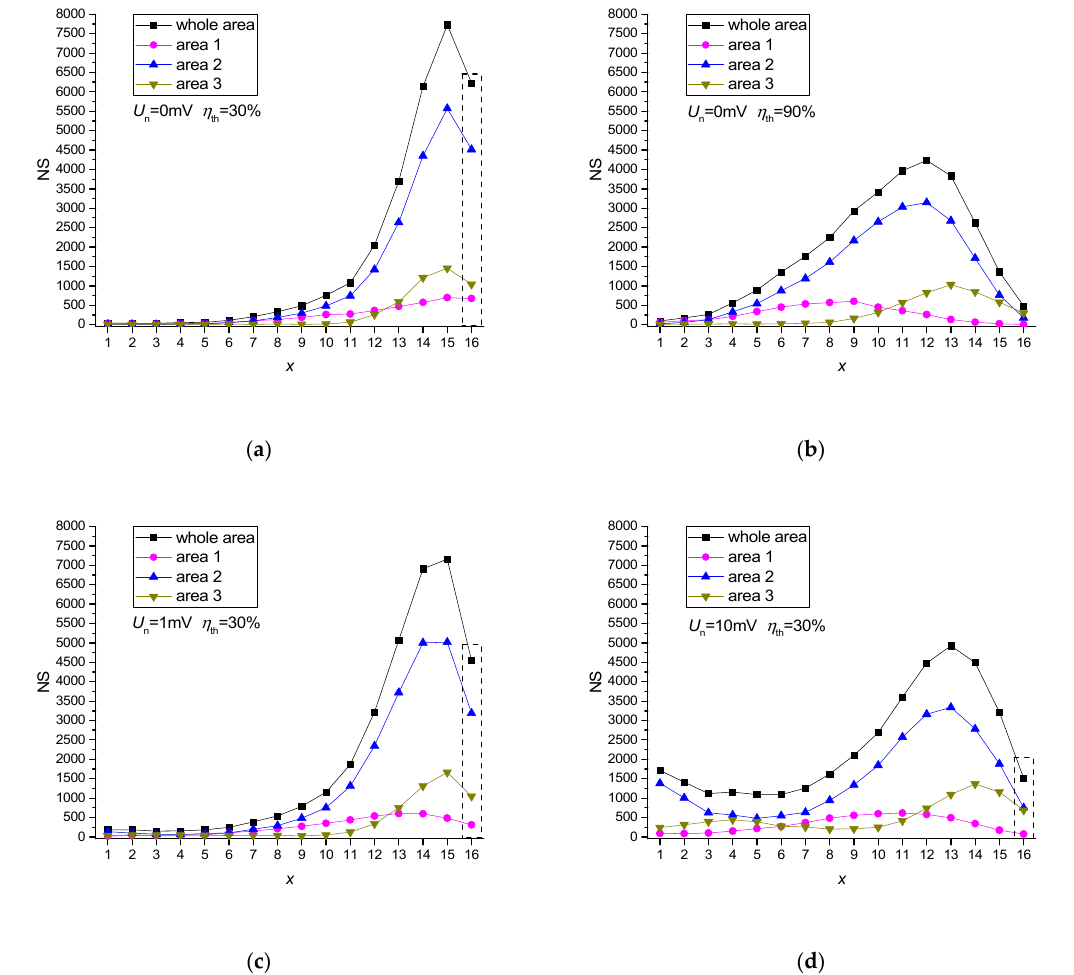
Figure 16. Distribution of the number of NS solutions to the “ x of x ” problem for different areas of the I ON - I OFF space, taking into account chimeric synchronization. Calculation parameters are I p_0 = 1039 µA, I p_5 = 750 µA, ( a ) U n = 0 mV, η th = 30%, ( b ) U n = 0 mV, η th = 90%, ( c ) U n = 1 mV, η th = 30%, ( d ) U n = 10 mV, η th = 30%. The numbers of the regions correspond to Figure 11. The dotted line highlights the area of the solutions to the “16 of 16” problem.